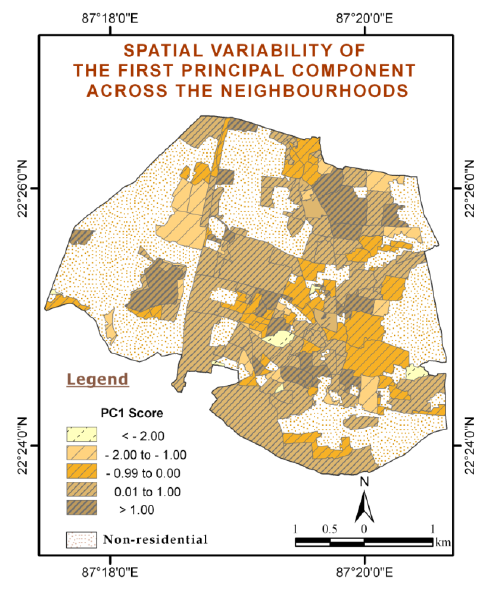
Figure 2. First Principal Component and NHs